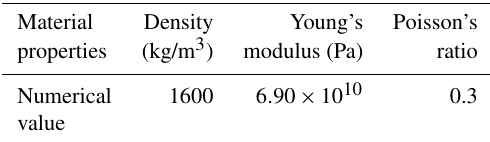
Table 1. Properties of carbon